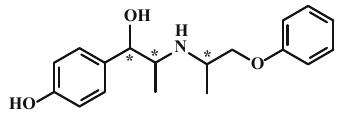
Figure 8: Chemical structure of isoxsuprine.